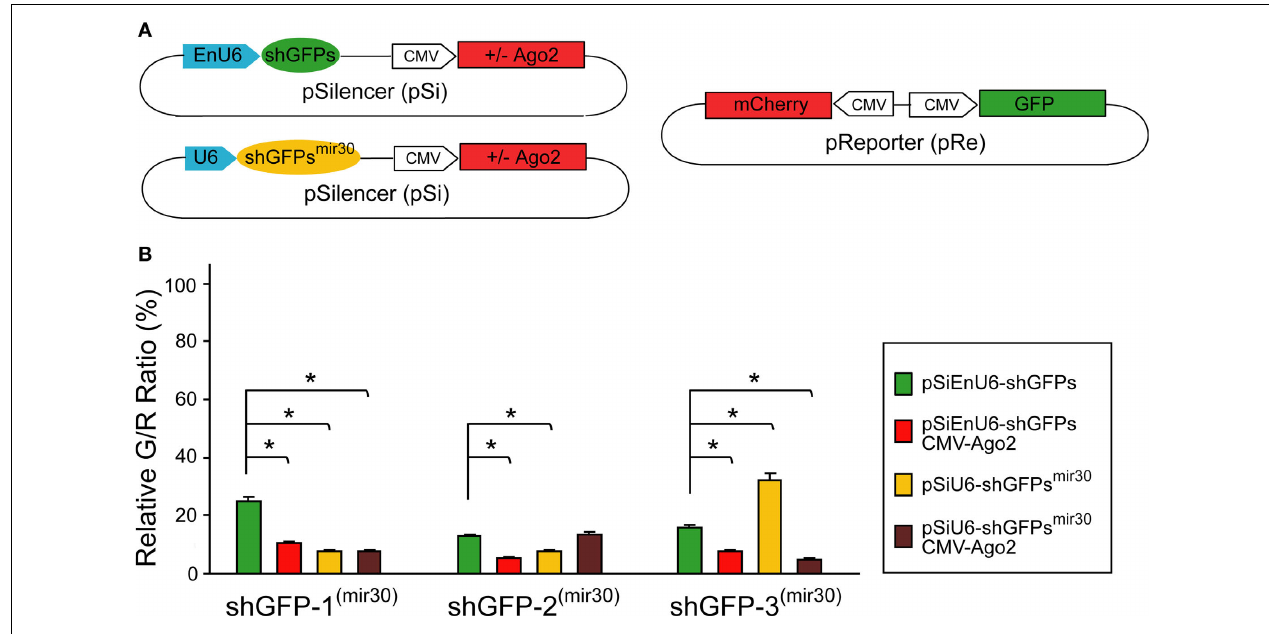
FIGURE 3 | Effect of shRNA structure on RNAi effi cacy. (A) Diagram of the pSi constructs containing shGFP or shGFP mir30 with or without Ago2 co-expression (left), and the pRe construct (right) for simultaneous GFP and mCherry expression. (B) G/R fl uorescence intensity ratio measured from cells transfected with pSi constructs containing shGFP or shGFP mir30 with or without Ago2 co-expression.